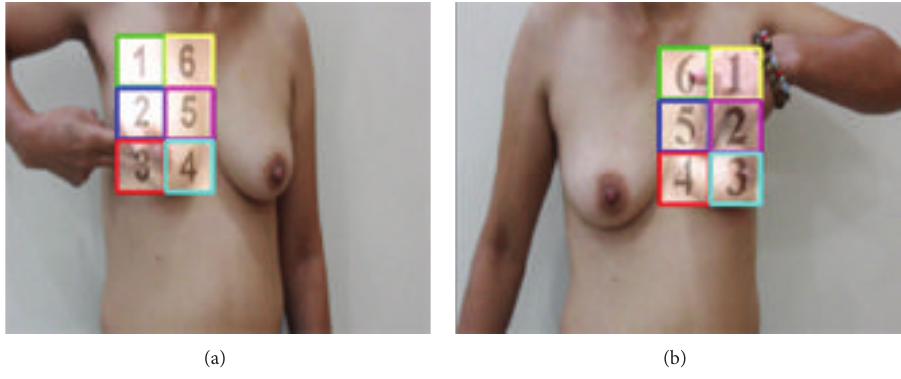
Figure 5: The samples of breast regions